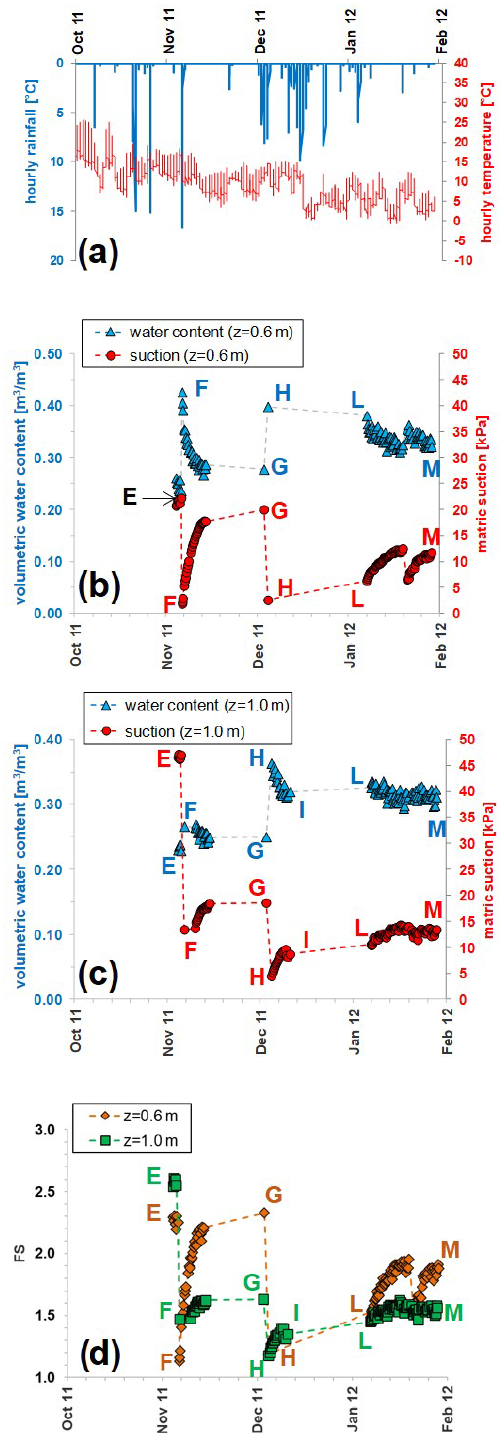
Figure 11. Monitored hourly weather data (a) , matric suction and volumetric water content from November 2011 to January 2012 at the depth z = 0.60m (b) and z = 1.00 (c) , and factor of safety, FS (d) , calculated by Eq. (2), provided by the simplified infinite slope model, and assuming a homogeneous deposit with slope an- gle α = 40 ◦ , unit weight γ = 14kNm − 3 , cohesion c (cid:48) = 0, friction angle ϕ (cid:48) = 38 ◦ , θ s = 0 . 75m 3 m − 3 , and θ r = 0.